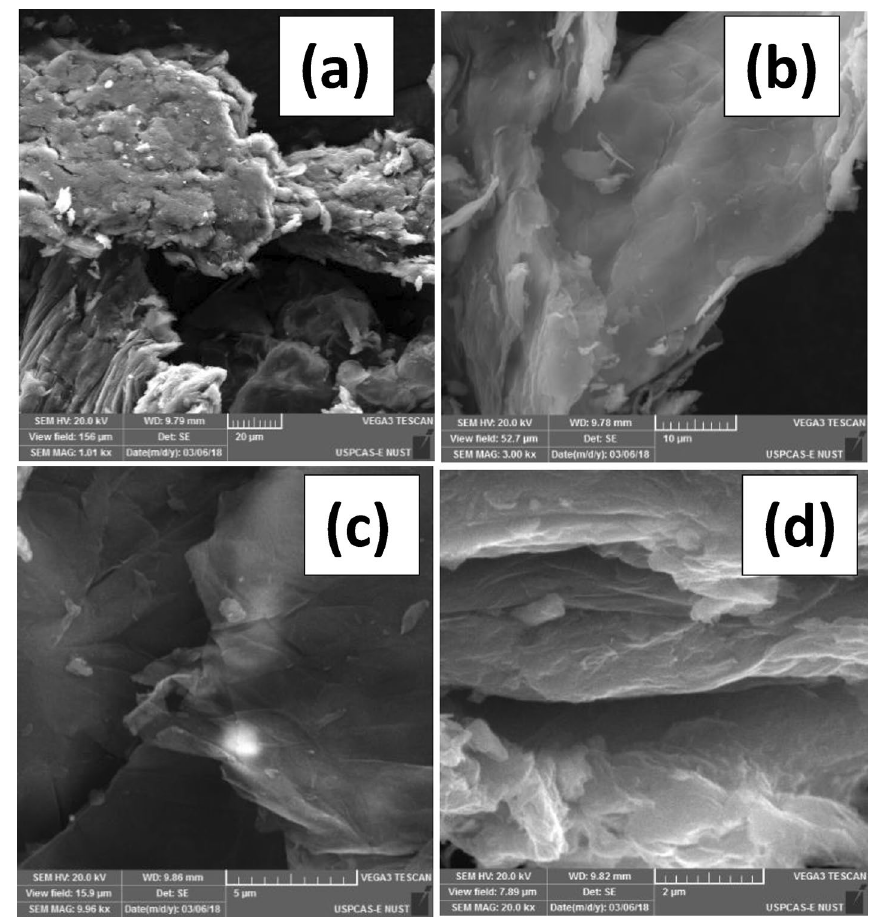
Figure 3. SEM images of pure graphene oxide nanosheets at different scale ( a ) 20 μm ( b ) 10 μm ( c ) 5 μm ( d ) 2